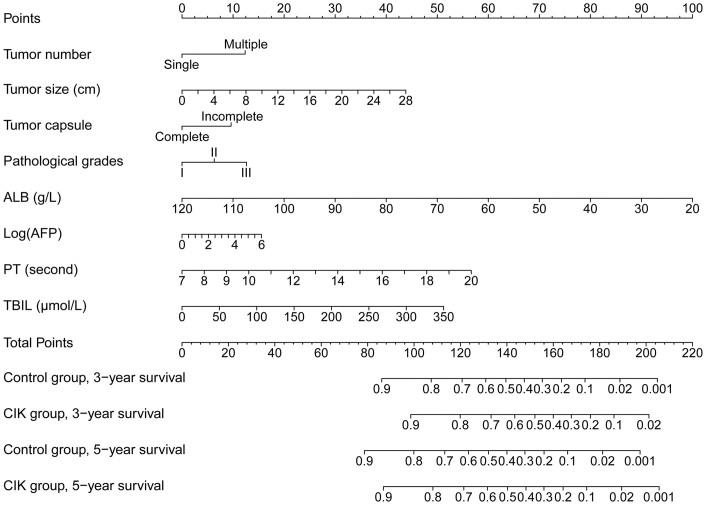
A nomogram for the prediction of 3- and 5-year overall survival for patients who receive adjuvant CIK cell treatment or surgery alone.The nomogram is used by totaling the points determined at the top of the scale for each factor. This total is then identified on the total points scale to determine the estimated probability of 3- and 5-year overall survival.